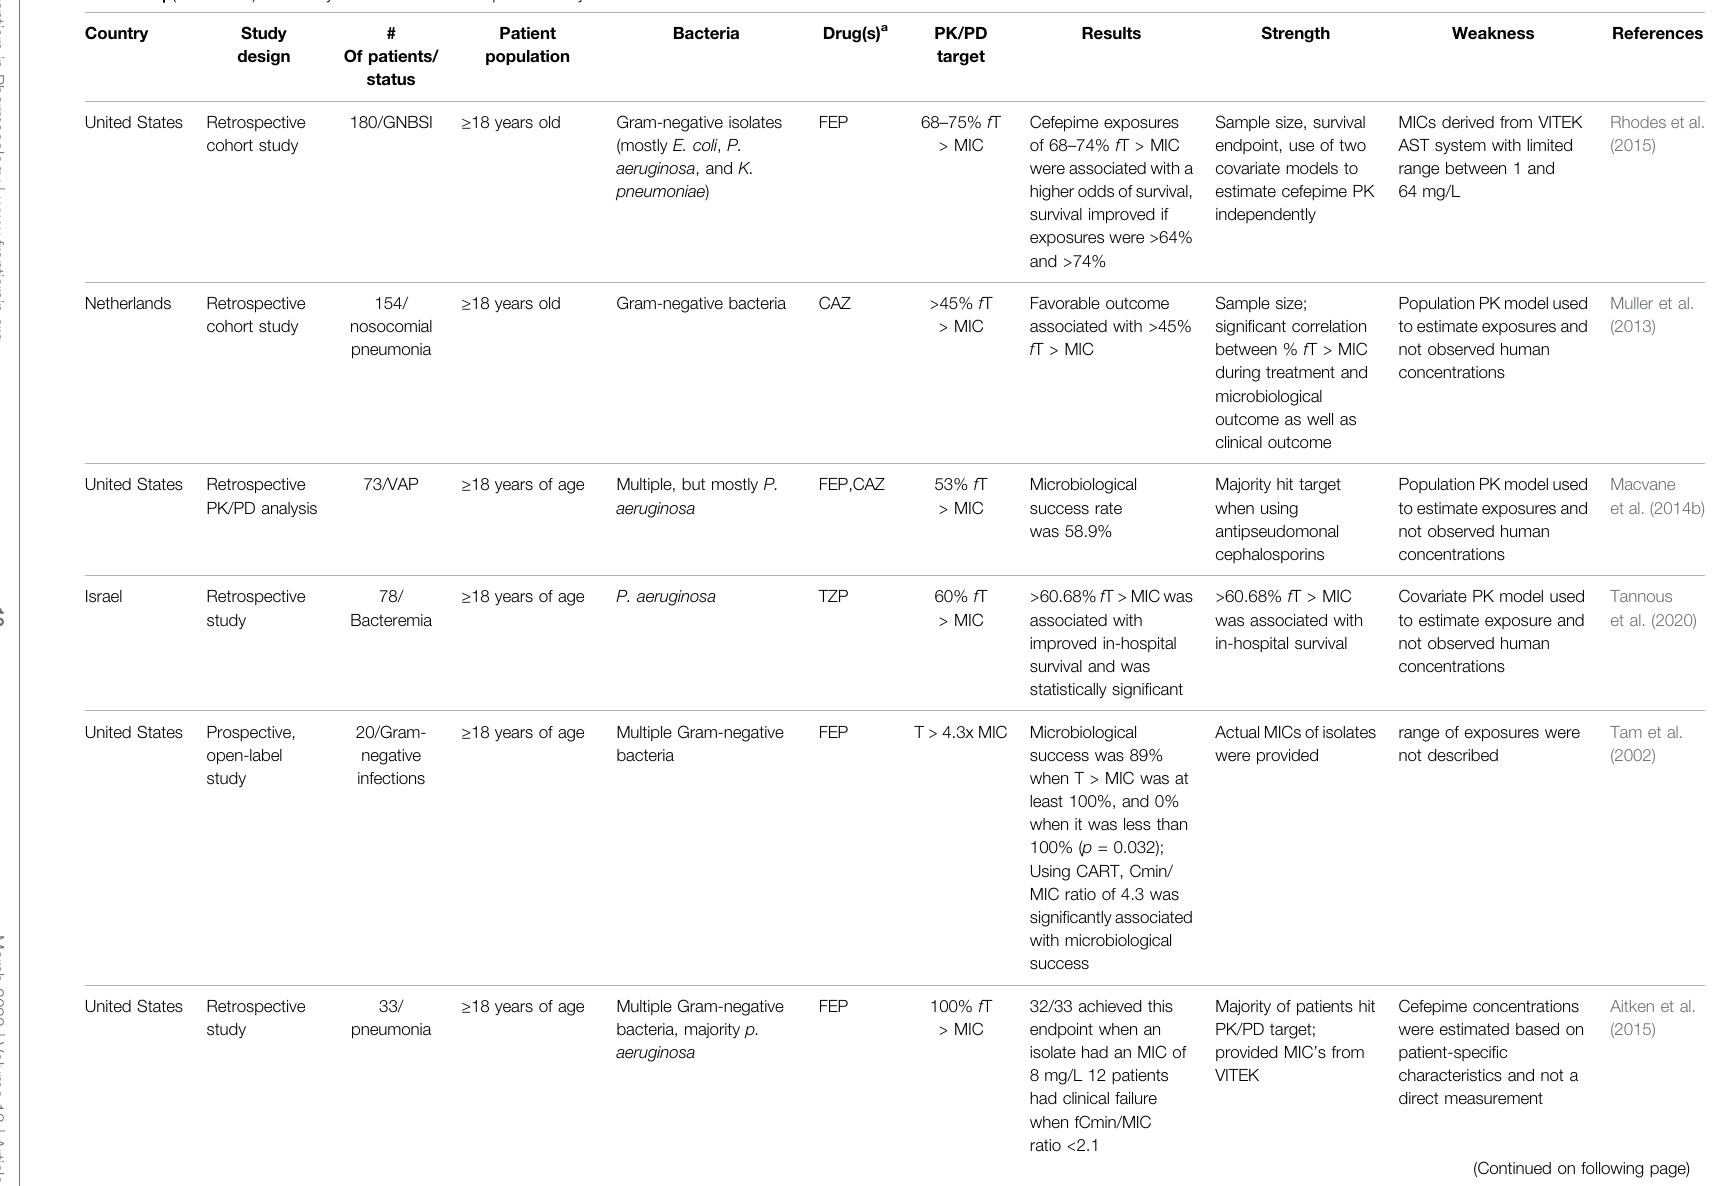
TABLE 1 | ( Continued ) Summary of details for clinical pharmacodynamic studies of